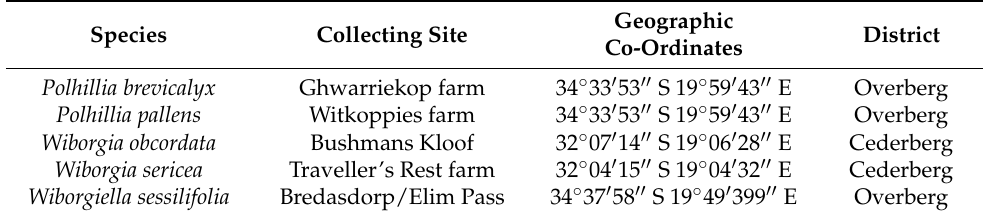
Table 1. Summary of plant species and their sample